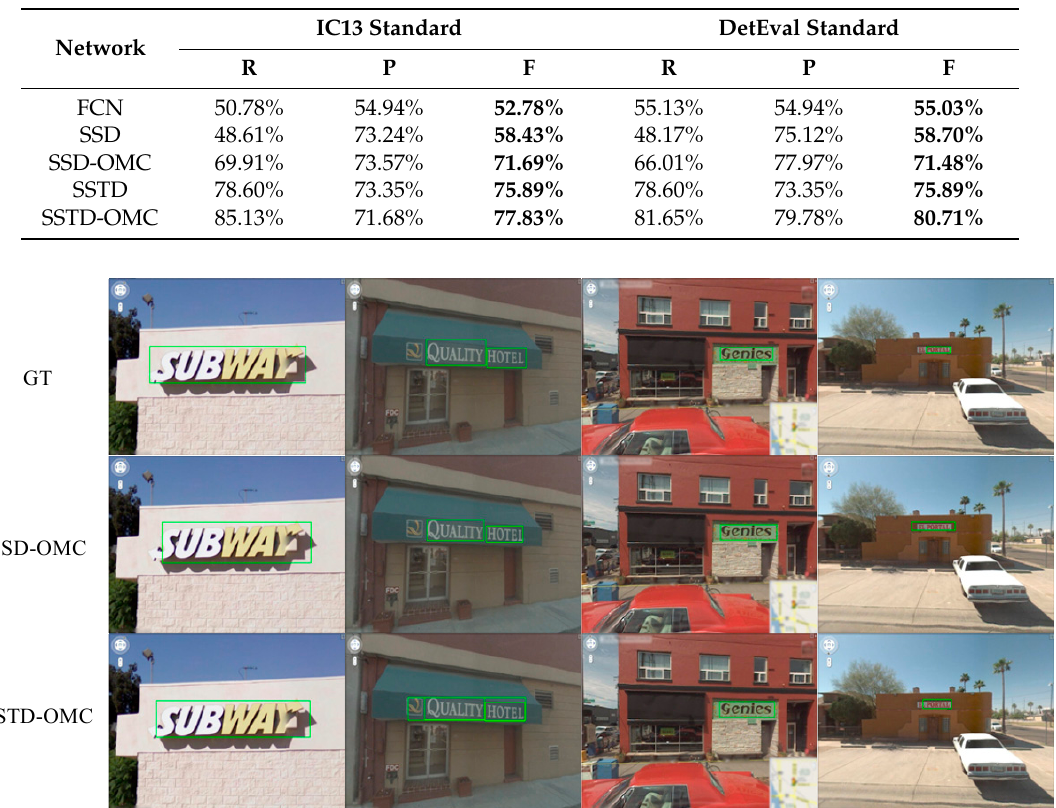
Figure 11. Some detection results and their ground truth from the SVT dataset.